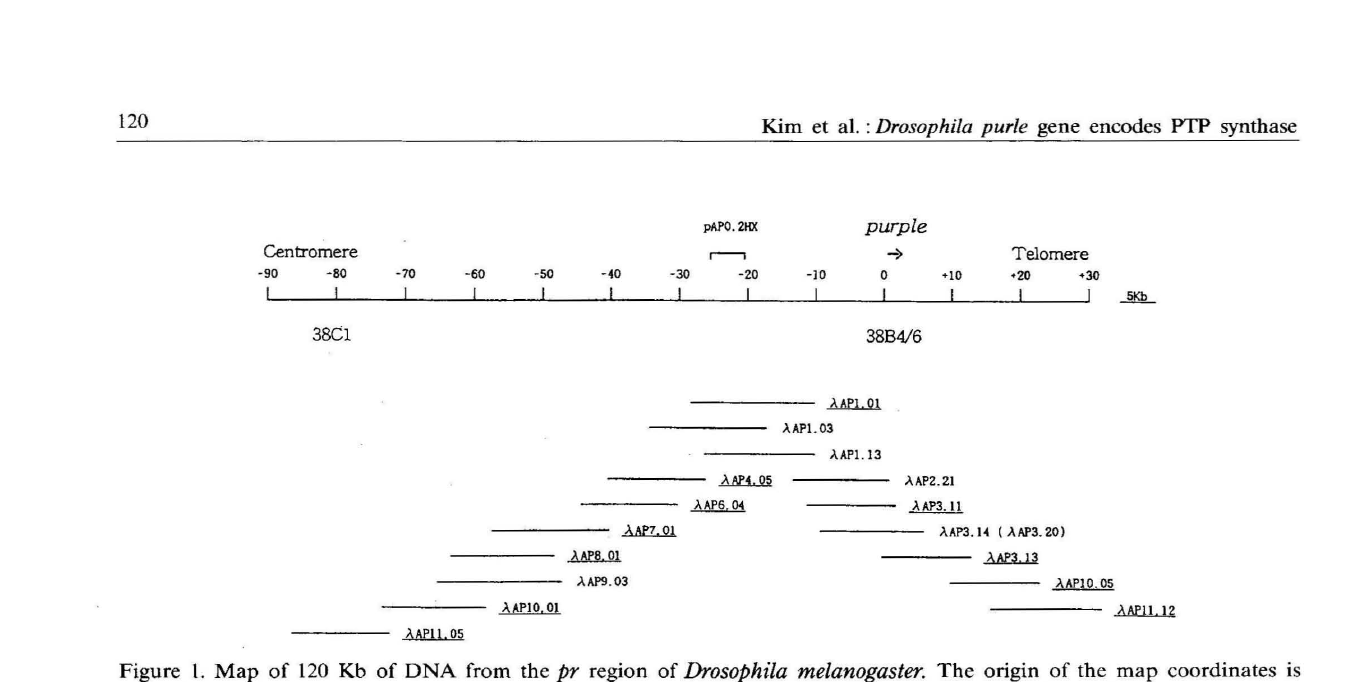
Figure 1. Map of 120 Kb of DNA from the pr region of Drosophila melanogaster. The origin of the map coordinates is the XbaI restriction enzyme site upstream to the transcriptional start site of the purple gene. The region and direction of purple transcription are indicated by the horizontal arrow. The plasmid DNA, pAPO.2HX, obtained from the tAP19 strain by PCR hybridized to the - 25 to - 20 region. The orientation of the cloned genomic DNA relative to centromere and telomere are denoted in the top. Underlined phage clones were used as the template DNA of the PCR reactions.